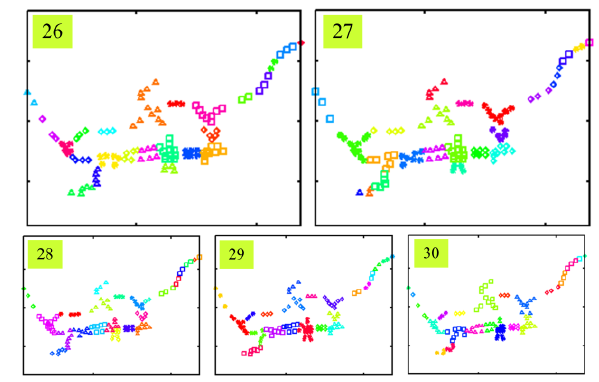
Figure 13. Clustering results for K inside interval [26,